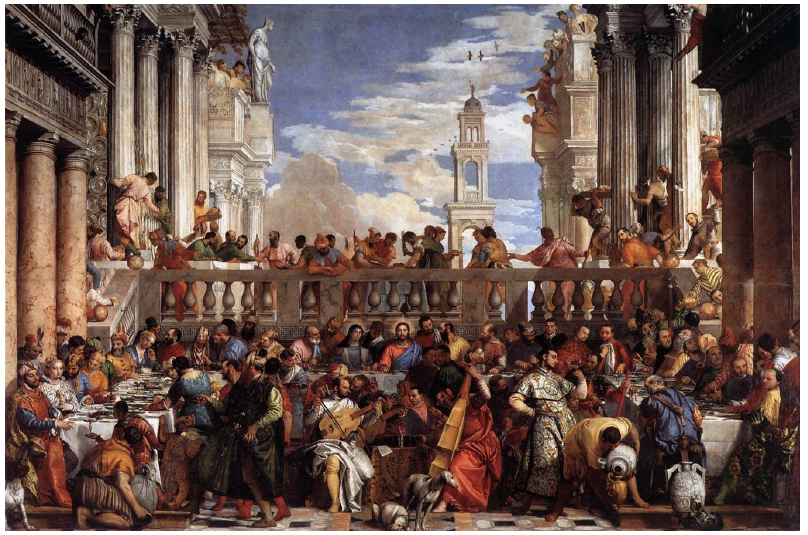
Figure 11. Paolo Veronese, Wedding at Cana , 1562/3, Louvre, Paris. Photo: Wikimedia Commons, Public Domain.